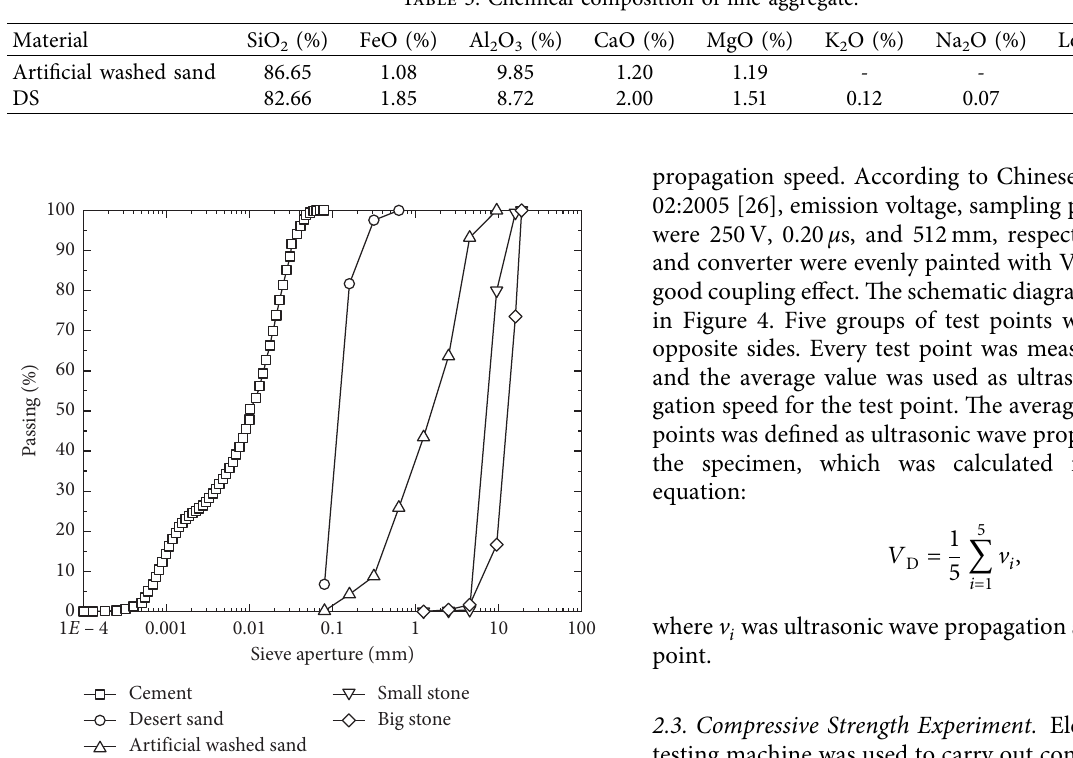
Figure 2: Gradation curves of raw